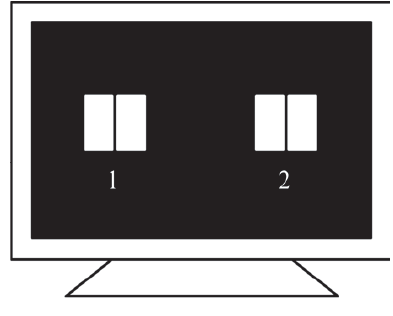
Figure 3. Visual stimulator presenting two half-field phase-tagged stimuli. (Left field of Flicker 1: 10.9 Hz and 0 deg, Right field of Flicker 1: 12 Hz and 0 deg, Left field of Flicker 2: 10.9 Hz and 0 deg, Right field of Flicker 2: 12 Hz and 180